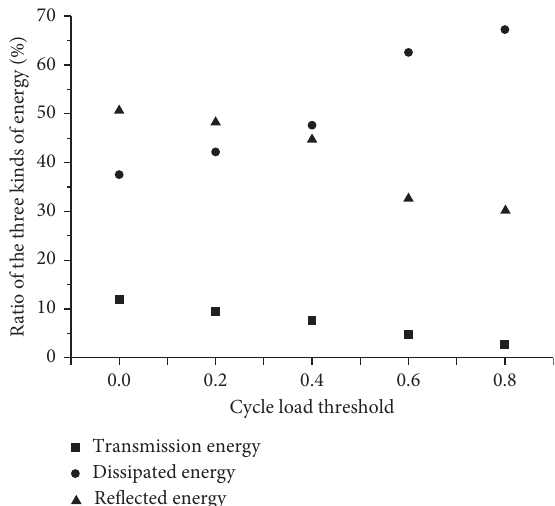
Figure 13: The proportion of the three energies to the incident energy at different cyclic